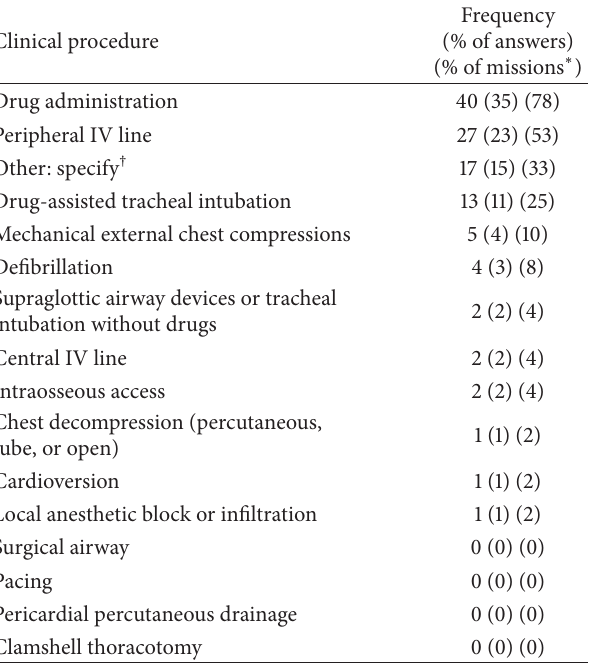
Table 5: Clinical procedures performed by HEMS crews during the study’s day.